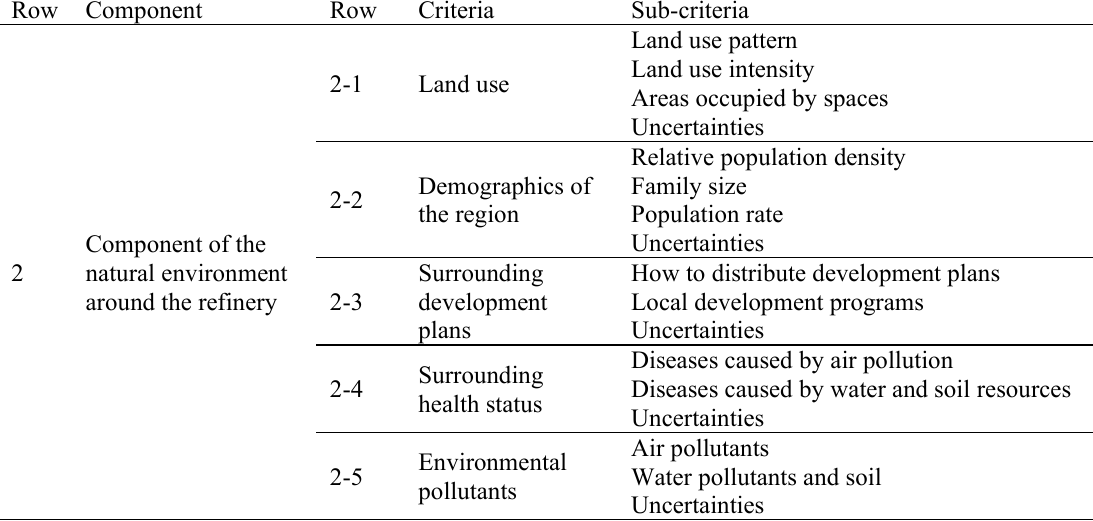
Table 2. Strategic components and criteria for component of natural environment around refinery Row